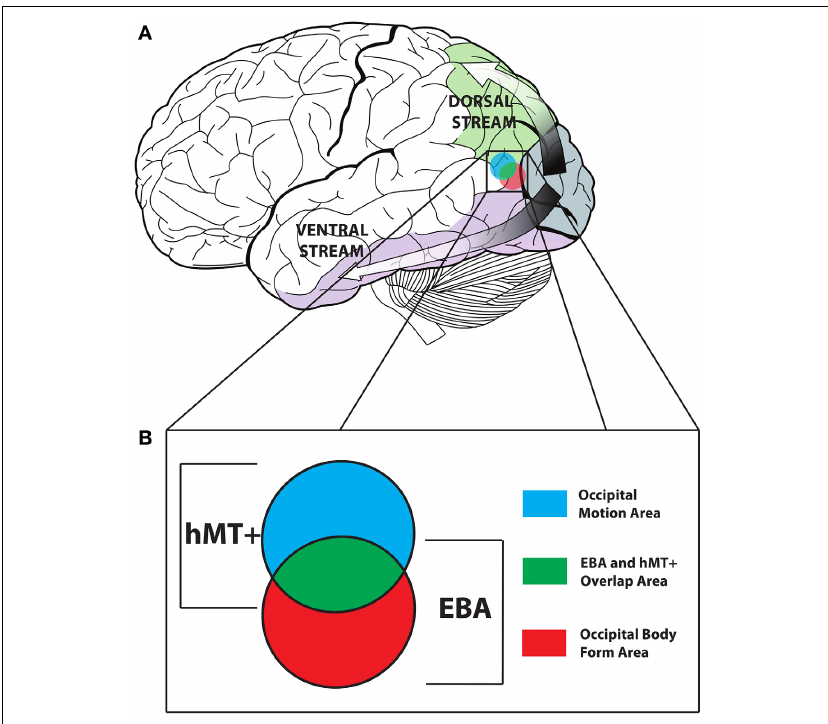
FIGURE 1 | (A) The dorsal (motion) and ventral (form) pathways of the visual system. (B) The overlap of EBA and hMT + is presented in Green. The Occipital Motion Area (formally hMT + ∗ ) is shown in Blue, and the Occipital Body Form Area (formally EBA ∗ ) is shown in Red. Adapted from an image created by Lokal_Profil,